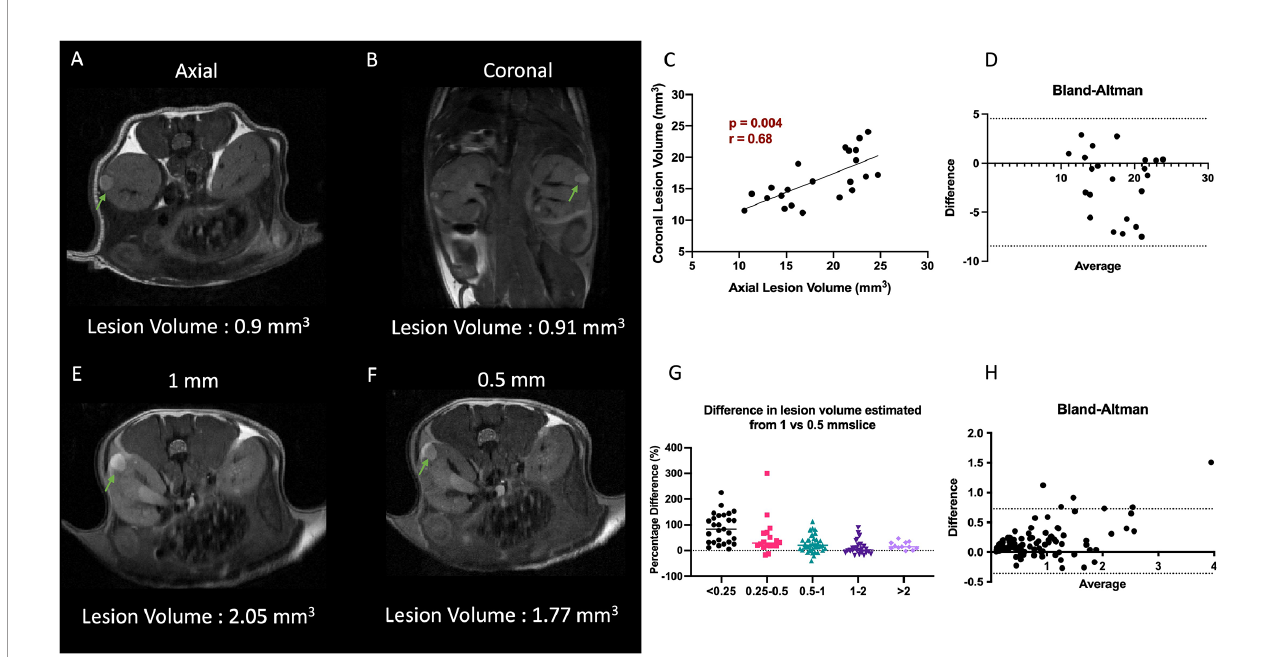
FIGURE 2 | Impact of slice orientation and thickness on volume estimation. (A, B) Representative T 2 -weighted axial and coronal images. (C) Comparison of axial vs coronal slice orientation and its effect on the tumor volume estimation. (D) Bland-Altman plot of differences and averages from axial and coronal lesion volumes. (E, F) Representative T 2 -weighted 1 mm and 0.5 mm slice thickness images. Lesions are highlighted with arrows. (G) Decrease in difference of volumes of lesion estimated from 0.5 and 1 mm thick slices as function of lesion volume. (H) Bland-Altman plot of differences and averages of lesion volumes from 1 mm and 0.5 mm thick images. Lesions are indicated with green arrows.